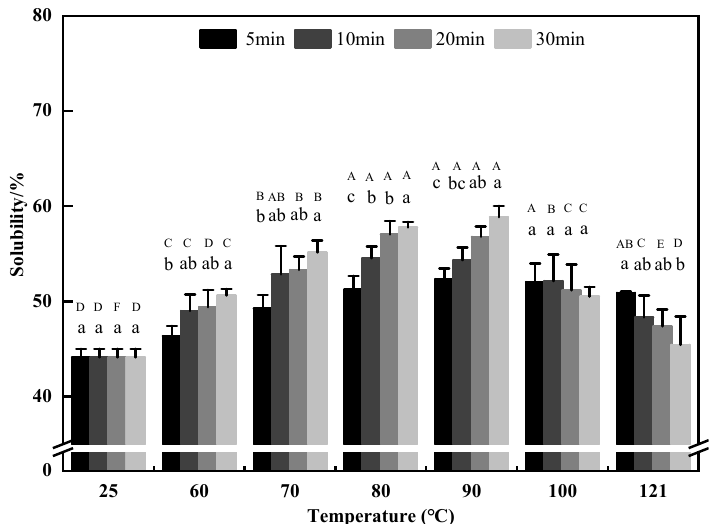
Figure 6. Effects of different hydrothermal treatment conditions on the solubility. A–F indicates the significant differences between different temperatures and a–c indicates the significant differences between different times ( p < 0.05).